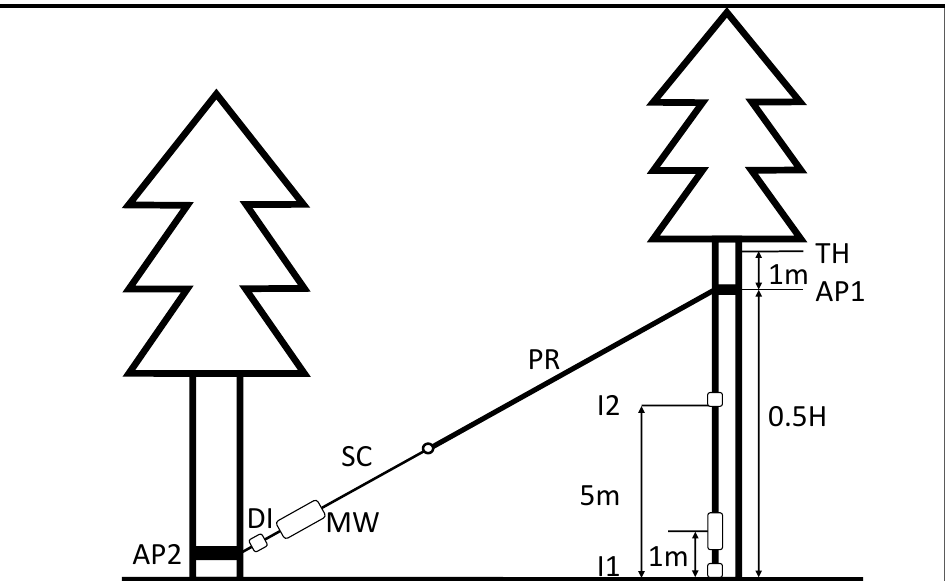
Figure 1. Schematic depiction of the static destructive pulling test setup. AP: anchorage point, DI: dynamometer (includes inclinometer for rope angle), I: inclinometer, MW: manual winch, TH: topping height; SC: steel cable; PR: polyester rope.